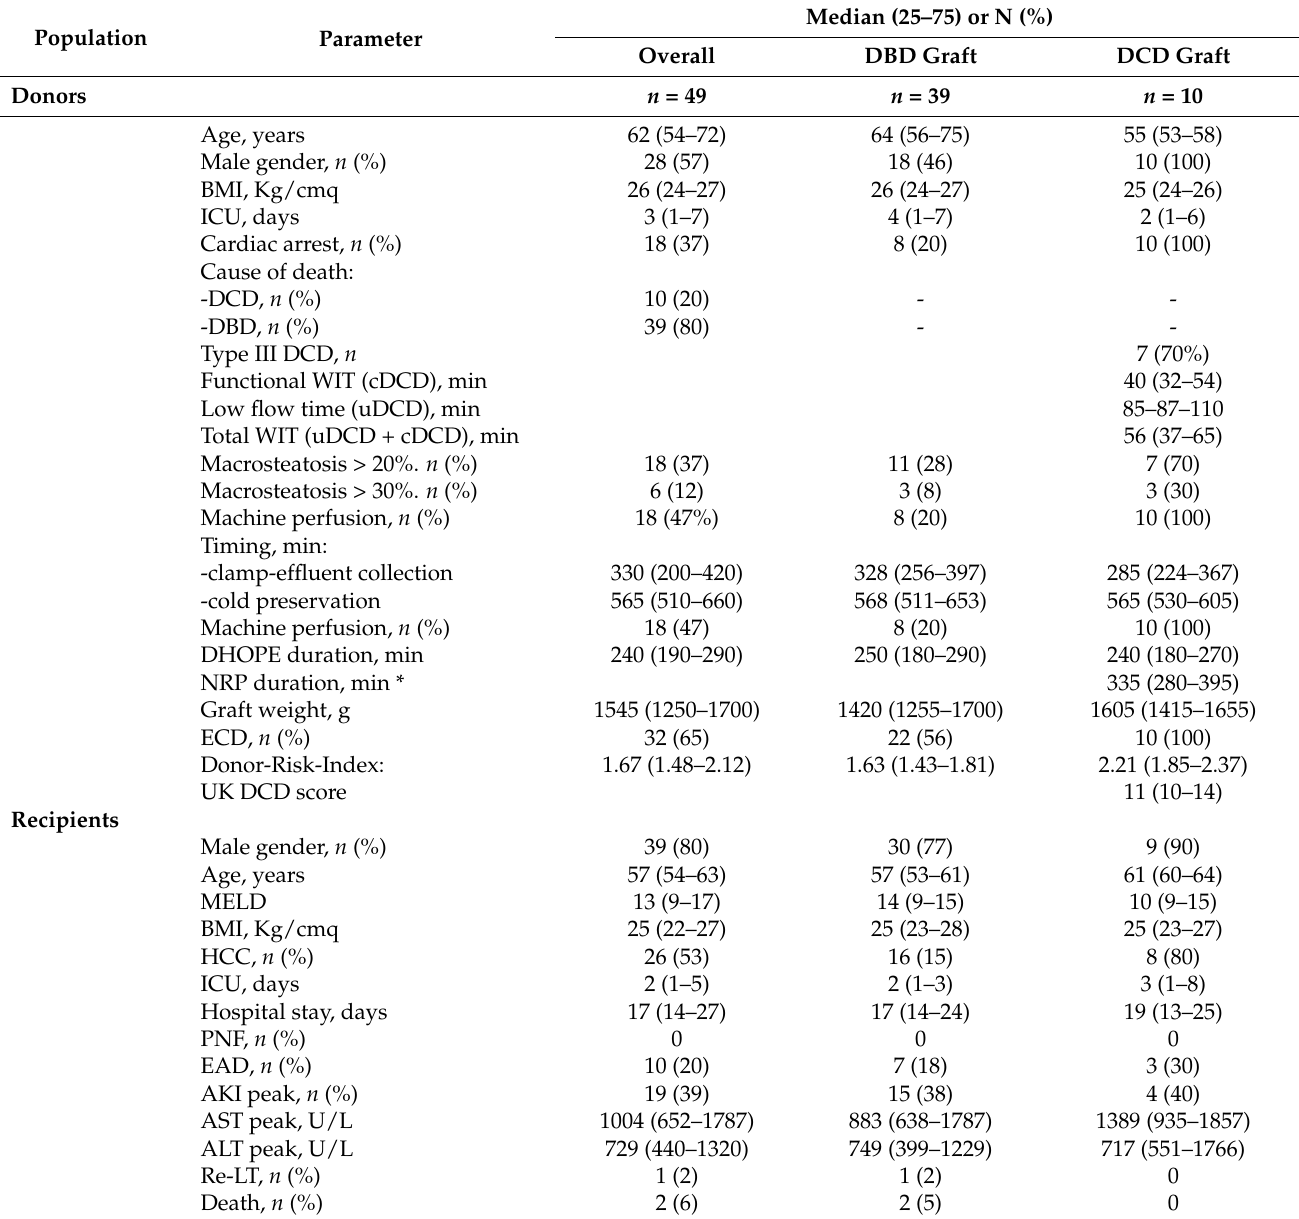
Table 1. Donor and recipient characteristics. Data are presented as median (25–75) or n (%), n = 49. Abbreviations: BMI, body mass index; ICU, Intensive care unit stay; DCD, cardiac death donors; DBD, brain death donors; WIT, warm ischemia time; cDCD, controlled or type III DCD; uDCD, uncontrolled or type II DCD; DHOPE, dual hypothermic oxygenated machine perfusion; NRP, normothermic machine perfusion; ECD, extended criteria donors; MELD, model for end-stage liver disease; HCC, hepatocellular carcinoma; PNF, primary non function; EAD, early allograft dysfunction; AKI, acute